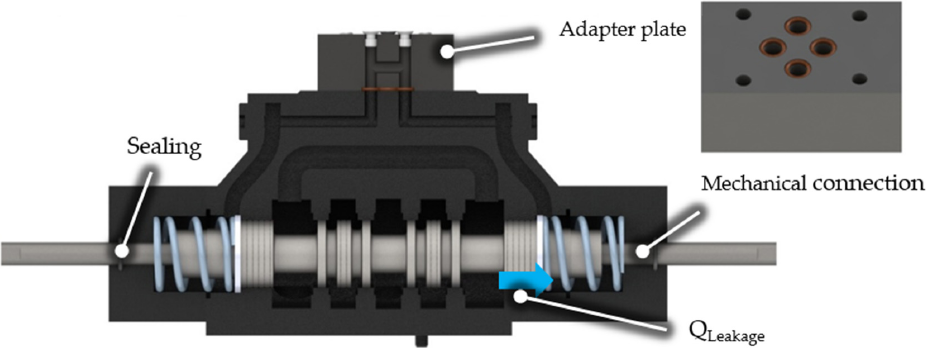
Figure 6. Special design details for an externally mounted electromechanical actuation system.